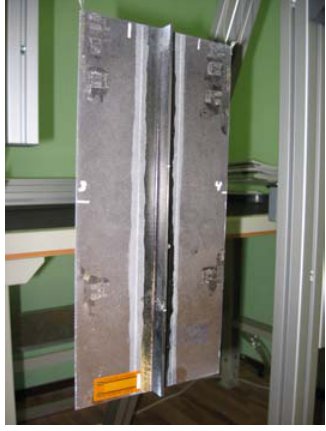
Fig 8. A stiffened composite panel with